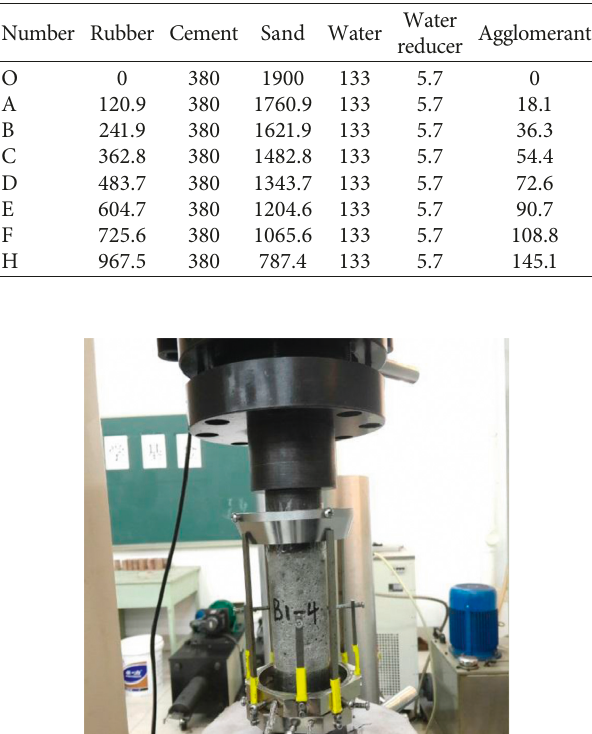
Figure 1: Rubber particles before and after surface-pretreated with NaOH saturated solution. Table 1: Mix proportion of rubber concrete in experiment (unit: kg/m 3 ).